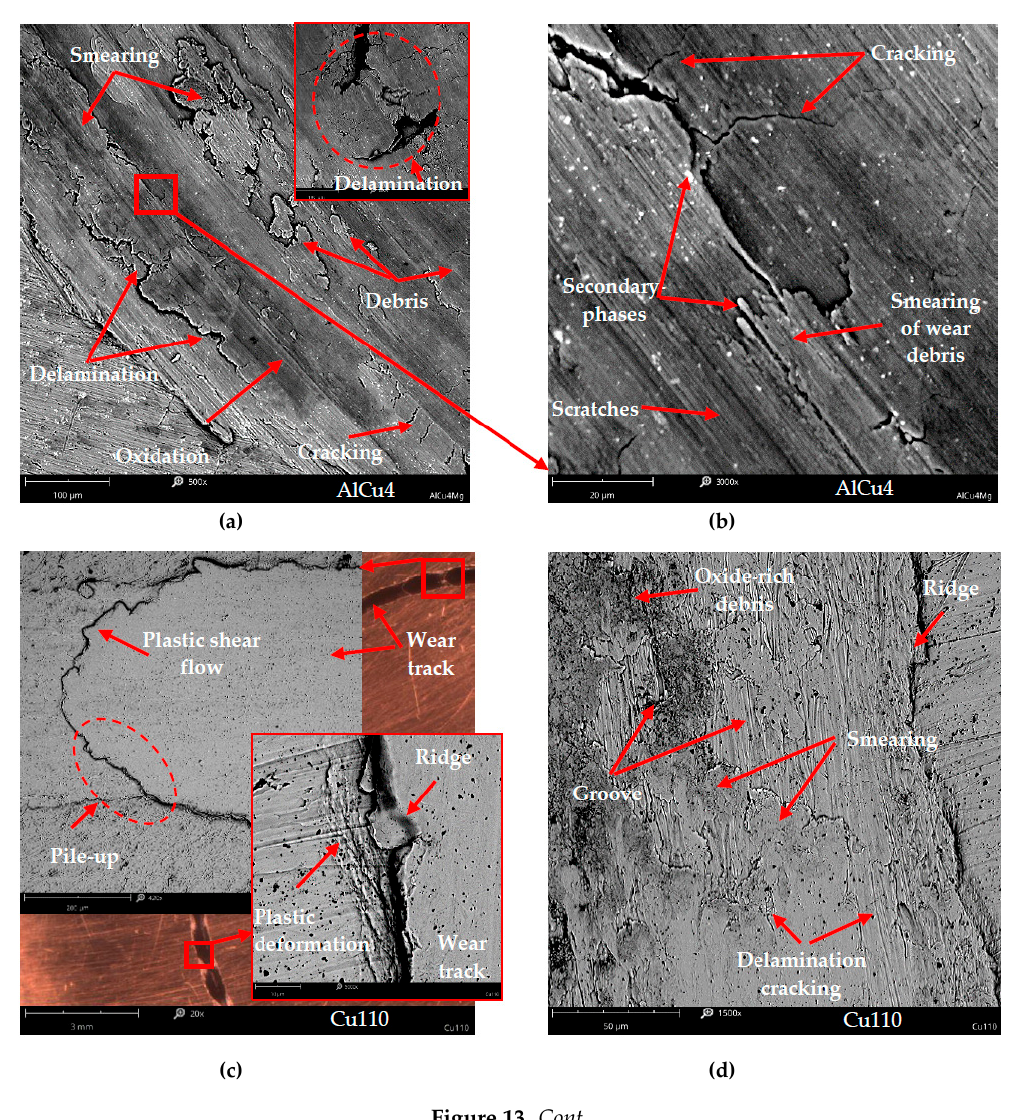
Figure 12. SEM images showing the wear track of cold-sprayed composites: ( a–d ) Al/Al 2 O 3 and ( e–h ) Cu/Al 2 O 3 .